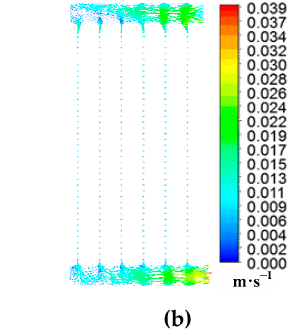
Figure 7. ( a ) Oil flow velocity distribution inside transformer (section view); ( b ) Oil flow velocity distribution inside radiator (section view).